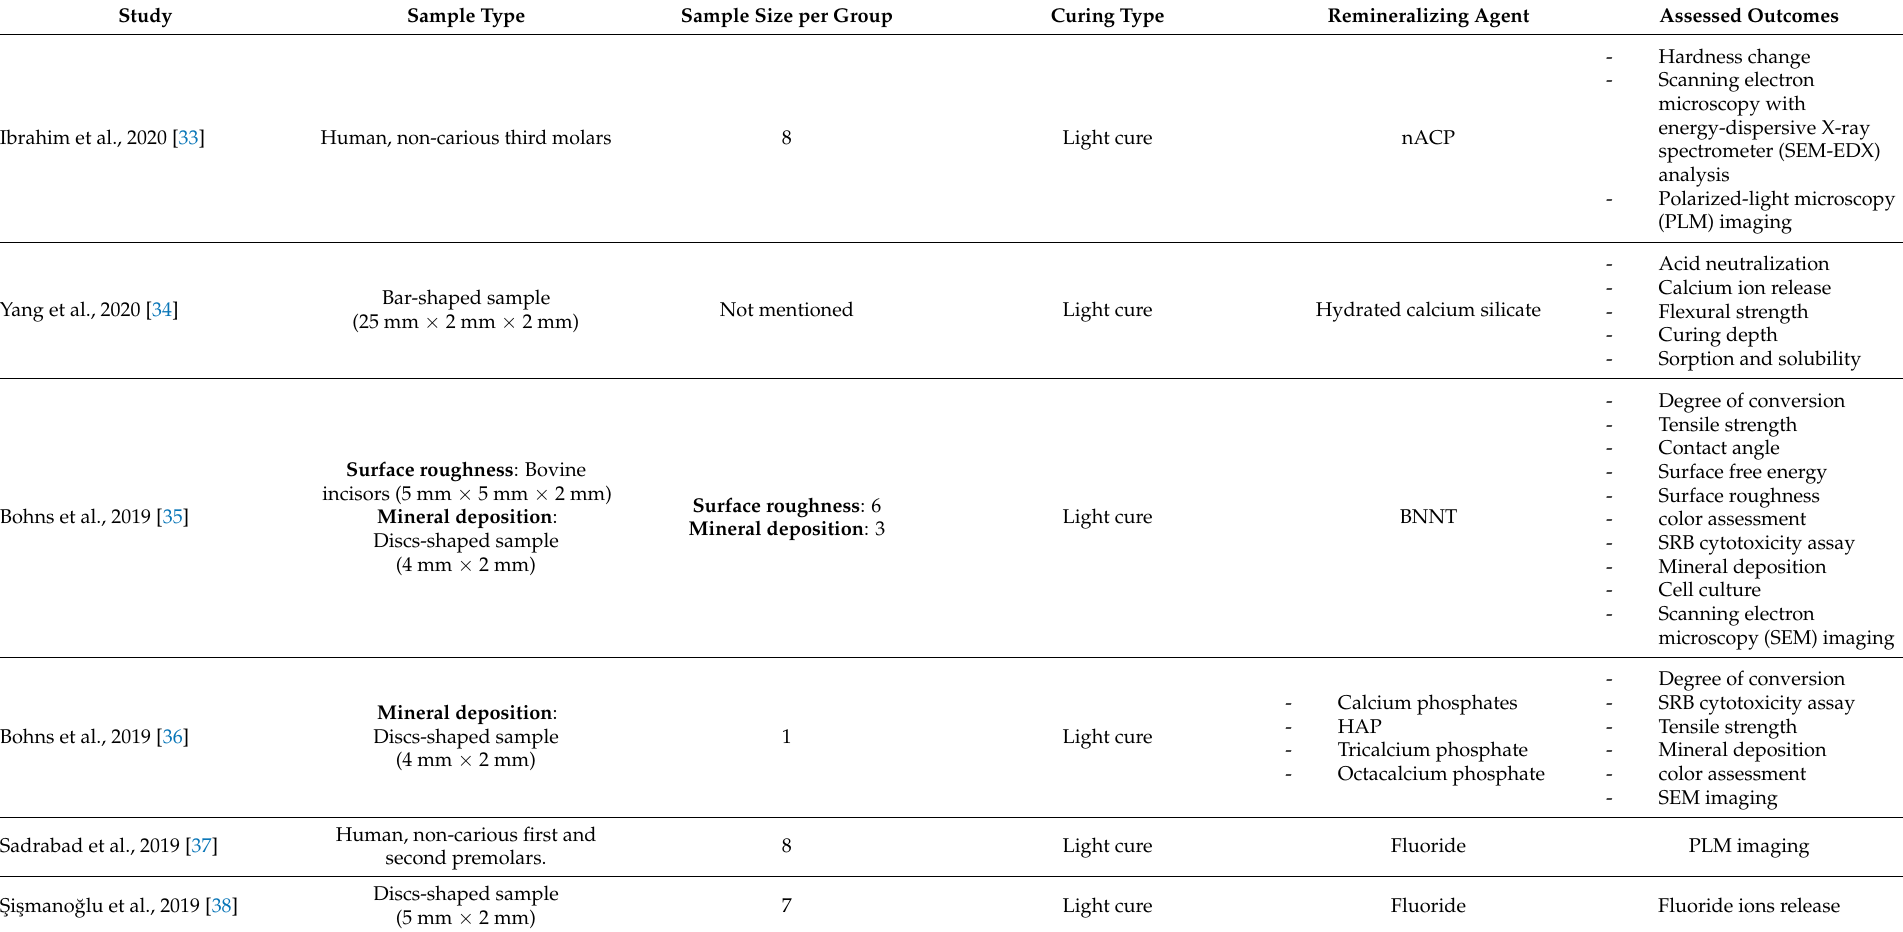
Table 2. Characteristics of the included